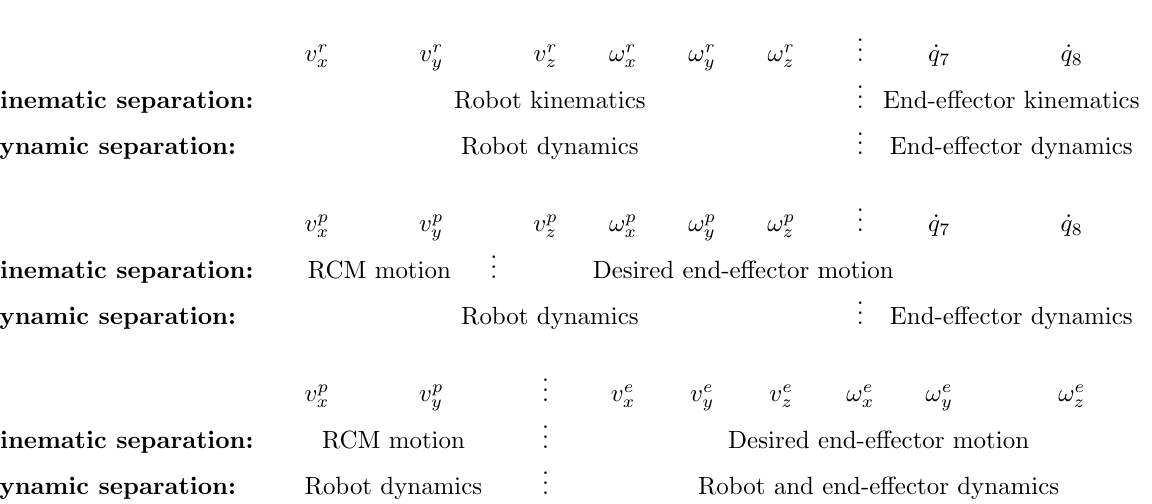
is convenient as the robot 0 r